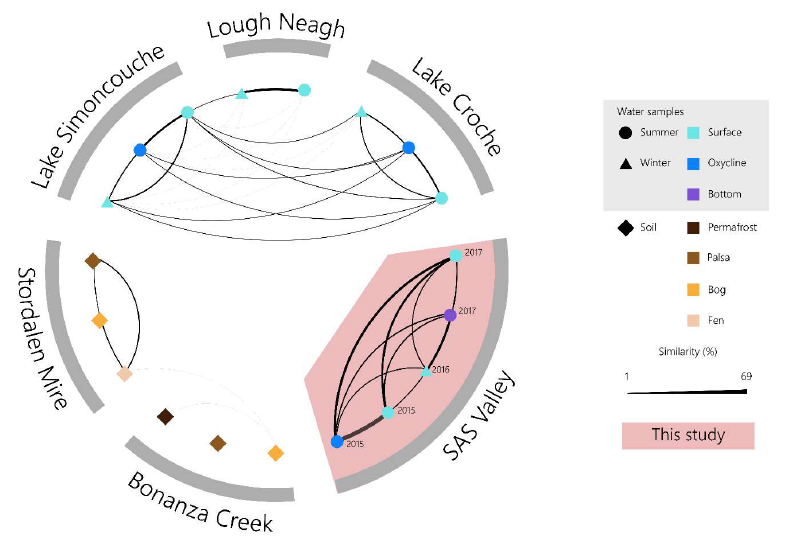
Figure 6. Genetic similarity between viral communities from various environments. Similarity was calculated with Libra using reads matched to contigs that were identified as viral (category 1 and 2) by VirSorter.